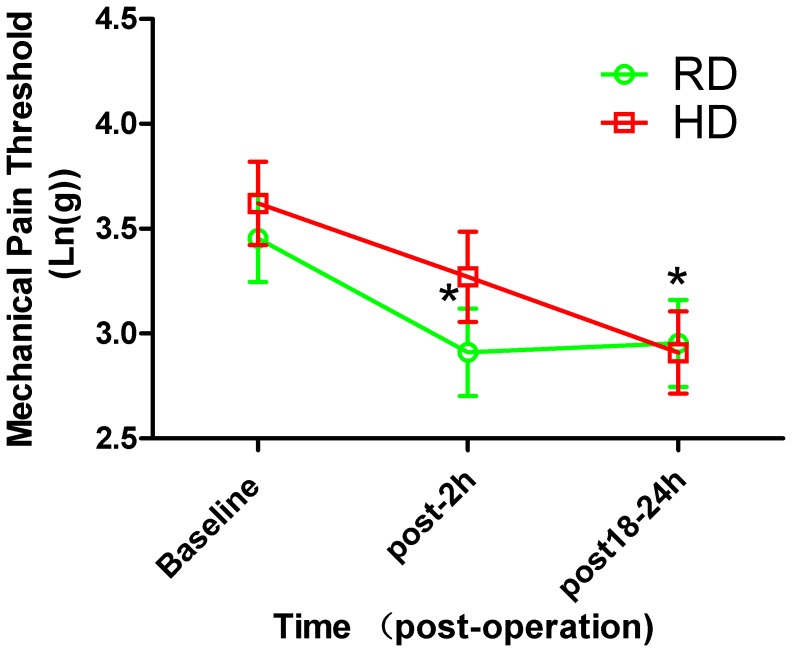
Time course of mechanical pain threshold in the forearm after surgery.Note the significantly decreased mechanical pain threshold at 2–24 h postoperatively compared to baseline in RD group (p<0.05, Two-way ANOVA analysis followed by Bonferroni’s post hoc test). In HD group, the mechanical pain threshold is also significantly decreased at 18–24 h postoperatively when compared with baseline (p<0.01, Two-way ANOVA analysis followed by Bonferroni’s post hoc test). *p<0.05, post-2 h or 18–24 h postoperatively vs baseline.